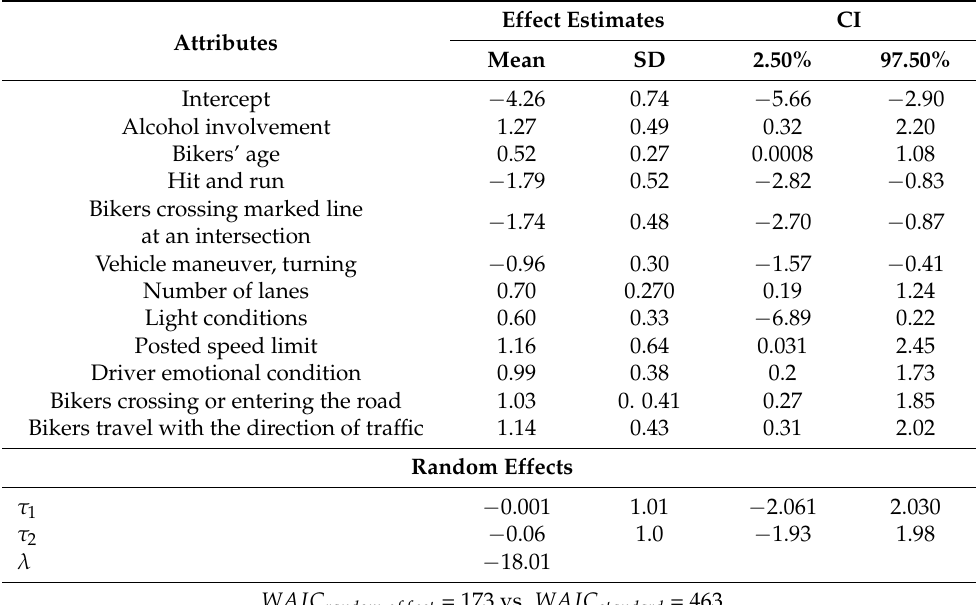
Table 2. Modeling results of bikers crash severity, HMC